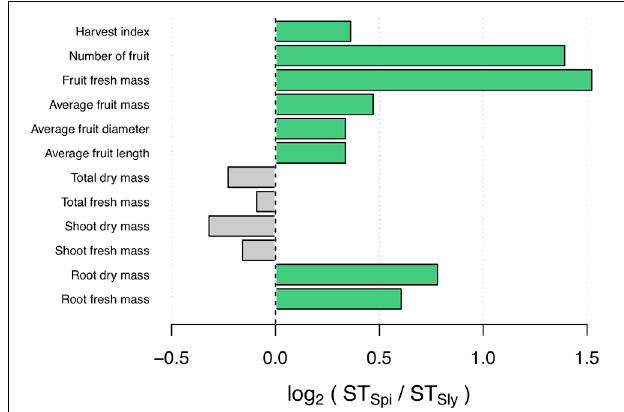
FIGURE 1 | Comparison of S. pimpinellifolium and S. lycopersicum salinity tolerance (ST) indices across various traits measured in the field (log 2 ratio). Traits for which the ST index is higher in S. pimpinellifolium and S. lycopersicum are in green and gray,